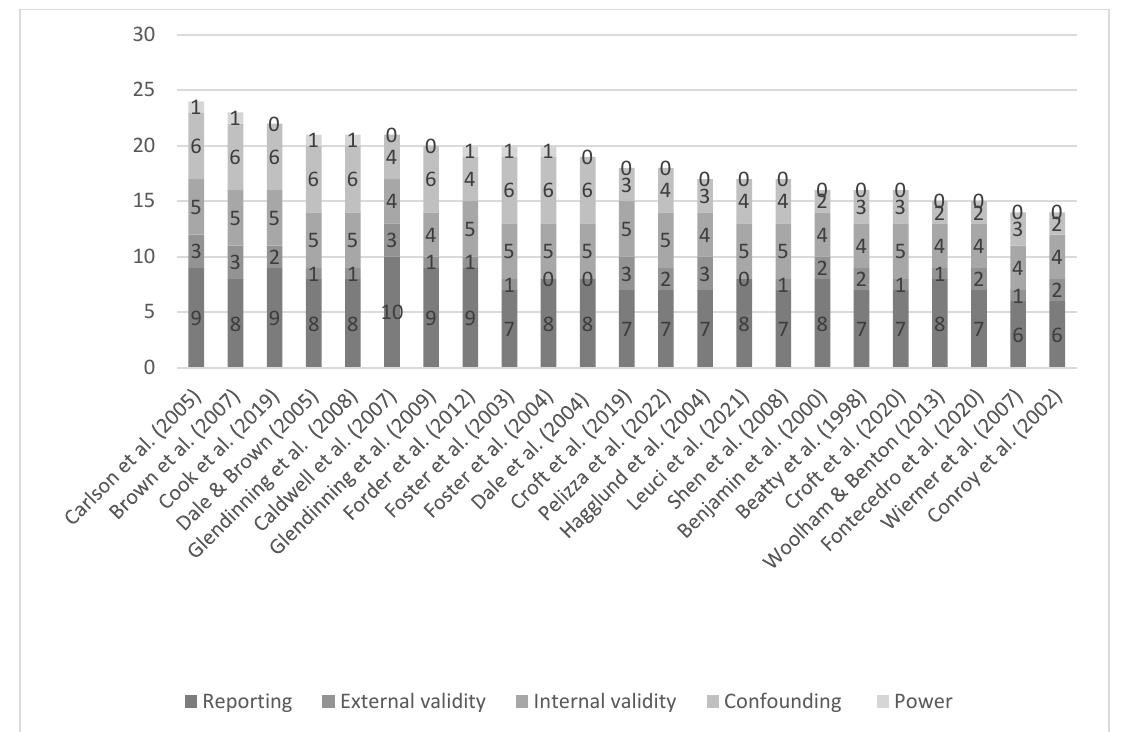
Figure 2. Quality assessment scores from the Downs and Black checklist.